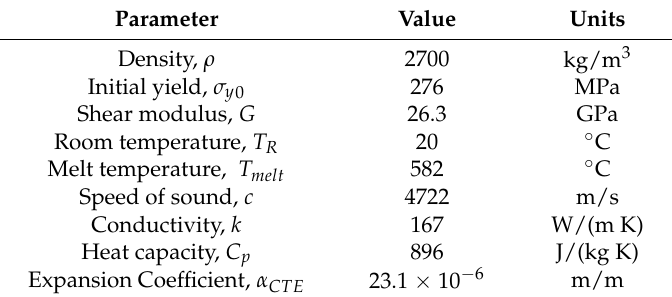
Table 6. Work piece thermophysical properties